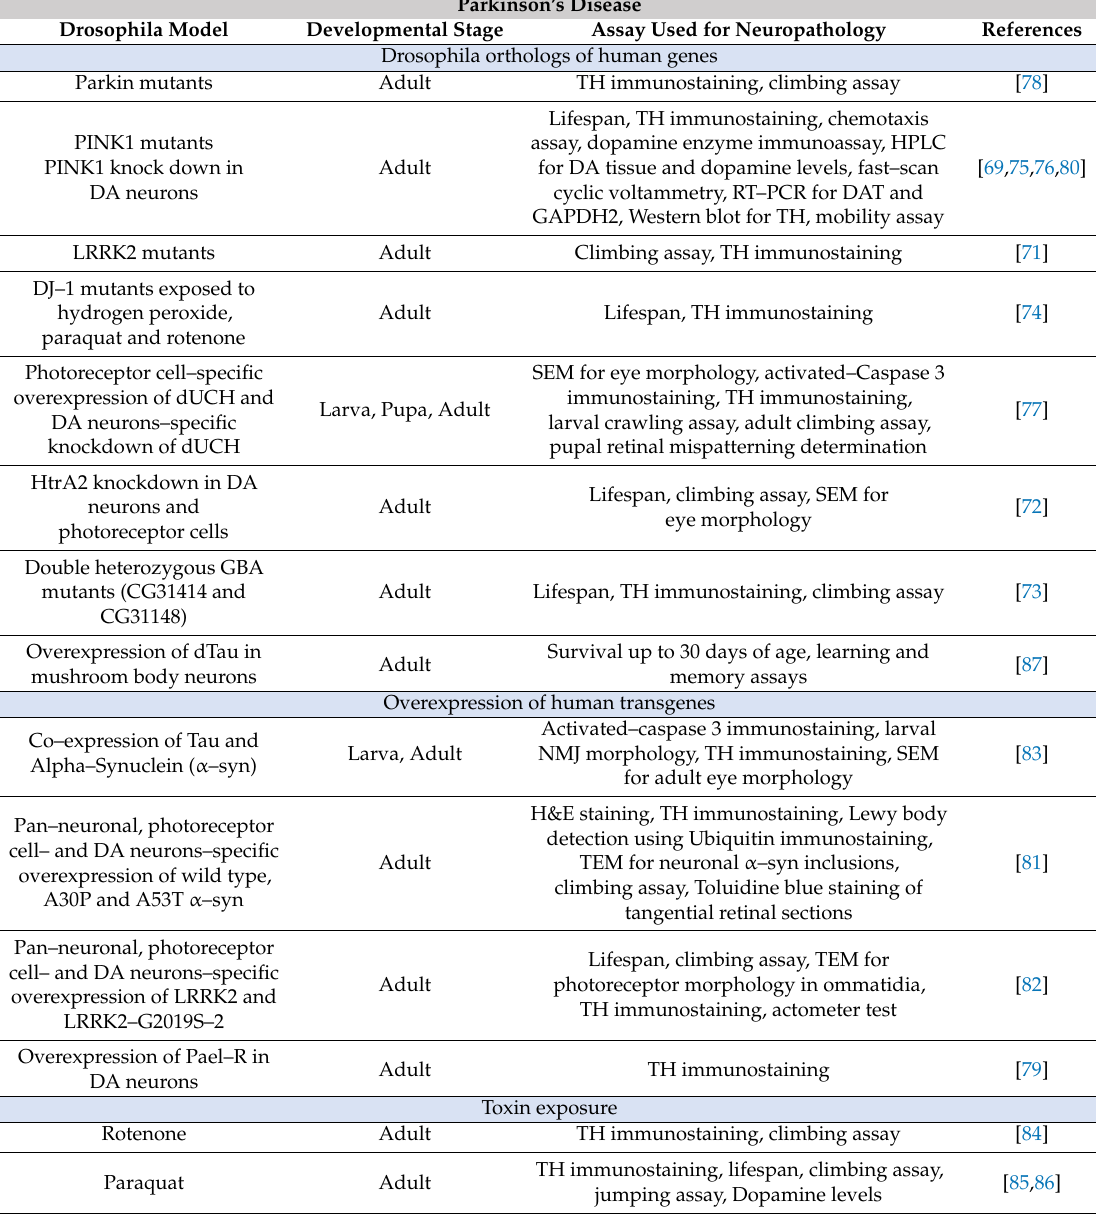
Table 2. Drosophila models of Parkinson’s